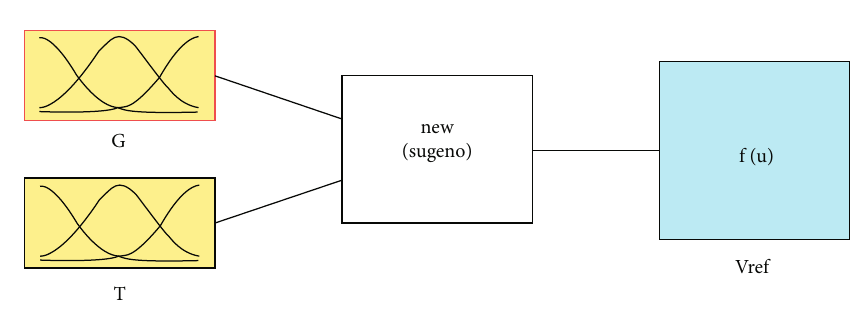
Figure 3: Architecture of an ANFIS.